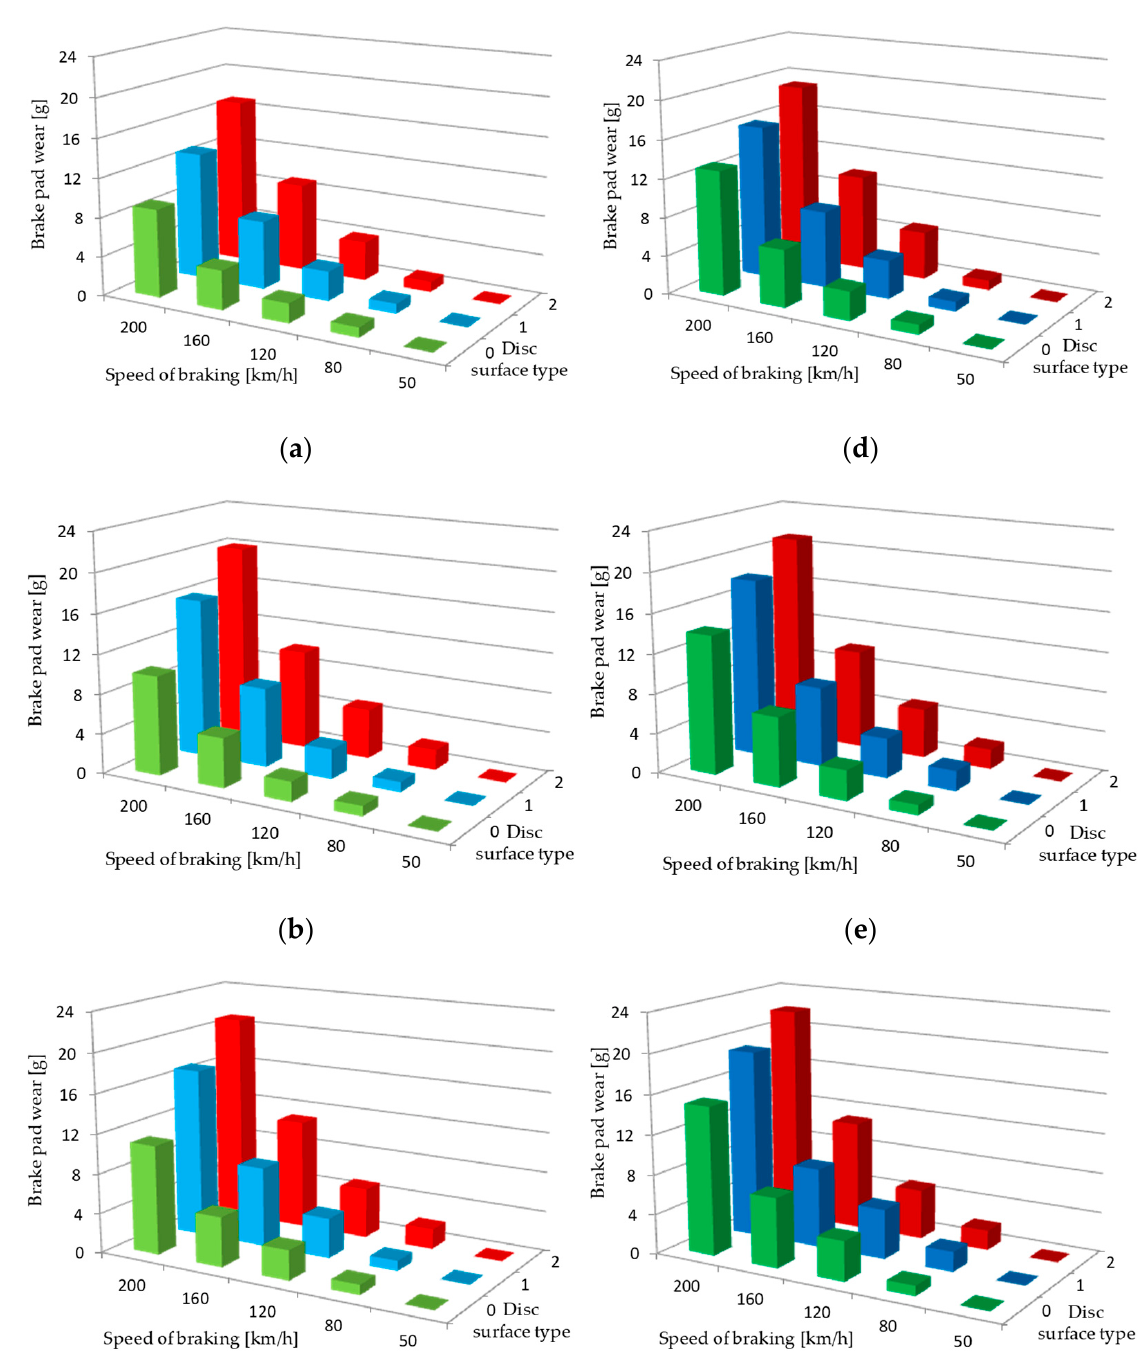
0—Brake pad on the disc without cuts, 1—Brake pad on a disc with one cut, 2—Brake pad on a disc with two cuts Figure 6. View of weight wear of friction pads under braking: ( a ) N = 25 kN, M B = 5.7 t (for 35 mm pad), ( b ) N = 25 kN, M B = 5.7 t (for 25 mm pad), ( c ) N = 25 kN, M B = 5.7 t (for 15 mm pad), ( d ) N = 36 kN, M B = 5.7 t (for 35 mm pad), ( e ) N = 36 kN, M B = 5. 7 t (for 25 mm facing), ( f ) N = 36 kN, M B = 5.7 t (for 15 mm facing), 0—smooth disc without perforations, 1—disc with one cut, 2—disc with two cut.